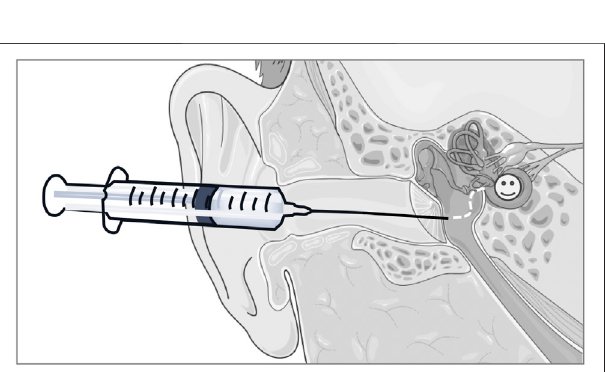
FIGURE 9 | Illustration of the rationale for the development of a liquid formulation that could be topically deployed into the middle ear of patients, from where it could subsequently, permeate across the RWM to access the cochlear structures susceptible to oxidative damage. The schematic art pieces used in this fi gure were created by using Servier Medical Art (http:// servier.com/Powerpoint-image-bank). Servier Medical Art by Servier